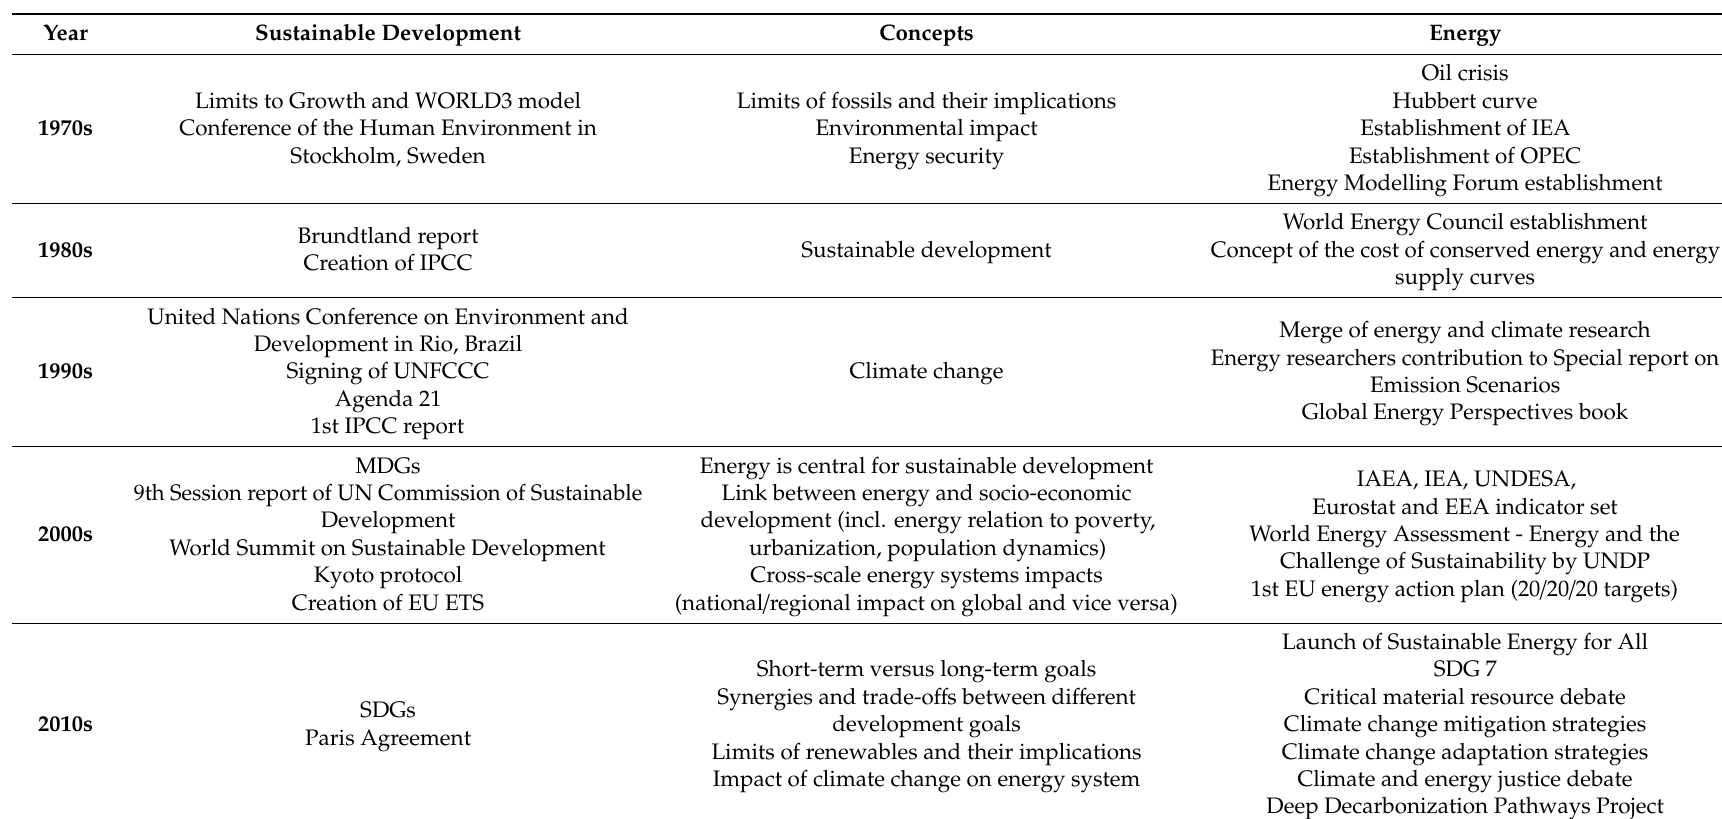
Table 1. Historical overview of the events and developments leading to the change of the energy paradigm and identified concepts (This table is based on a review of the following references: